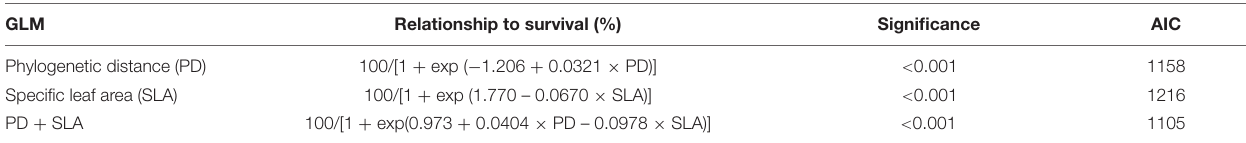
TABLE 2 | Plant traits predicting survival of Cassida rubiginosa resulting from the binomial generalised linear model (GLM) analyses. GLM Relationship to survival (%) Significance AIC Phylogenetic distance